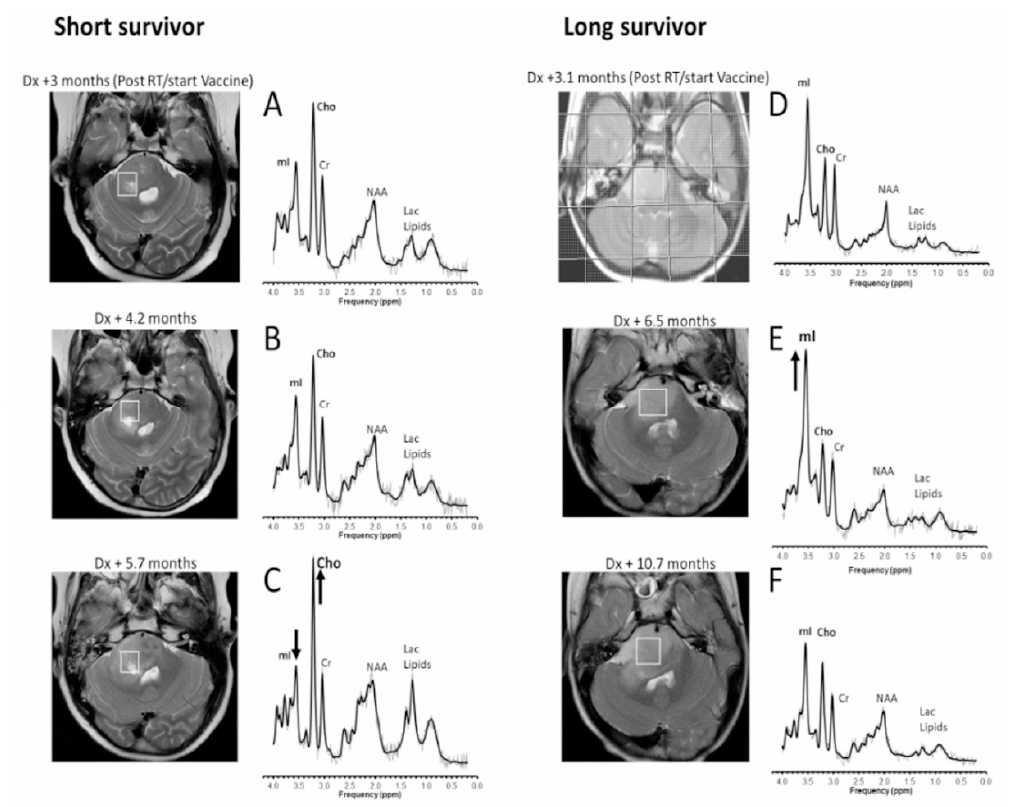
Figure 1. Transverse T2-weighted MRI and corresponding MR spectra. For a patient who survived 8.5 months after diagnosis (left column), metabolite levels at the start ( A ) and 1.5 months into vaccine therapy ( B ) are comparable. Soon before clinical and radiological deterioration ( C ), myo-inositol (mI) declined, and choline (Cho), lactate (Lac), and lipids all increased. For a patient who survived 23.6 months after diagnosis ( right column ), mI was prominent after completion of radiotherapy ( D ), and a further increase relative to Cho was noticeable 3 months after start of vaccine therapy ( E ). After another 4.2 months (and over a year before death) ( F ), a gradual decline of mI and a gradual increase in Cho were observed. Dx = diagnosis, RT = irradiation with or without concurrent chemotherapy, mI = myo-inositol, Cho = choline, Cr = creatine, Lac = lactate. Shown are the unfiltered raw data (thin line) and the fit to the data used for quantitation (thick line).